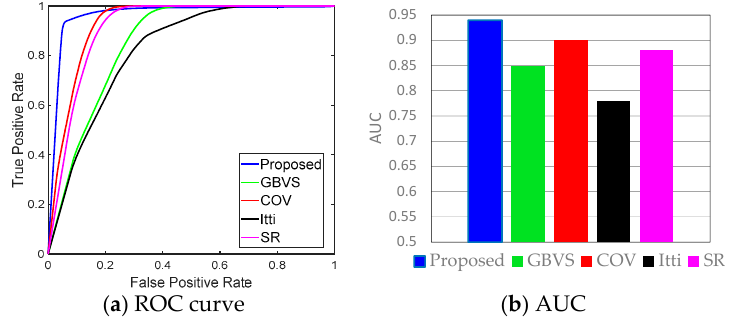
Figure 9. The performance of the saliency models under consideration in terms of receiver operating characteristic area under the curve (ROC-AUC) metric.